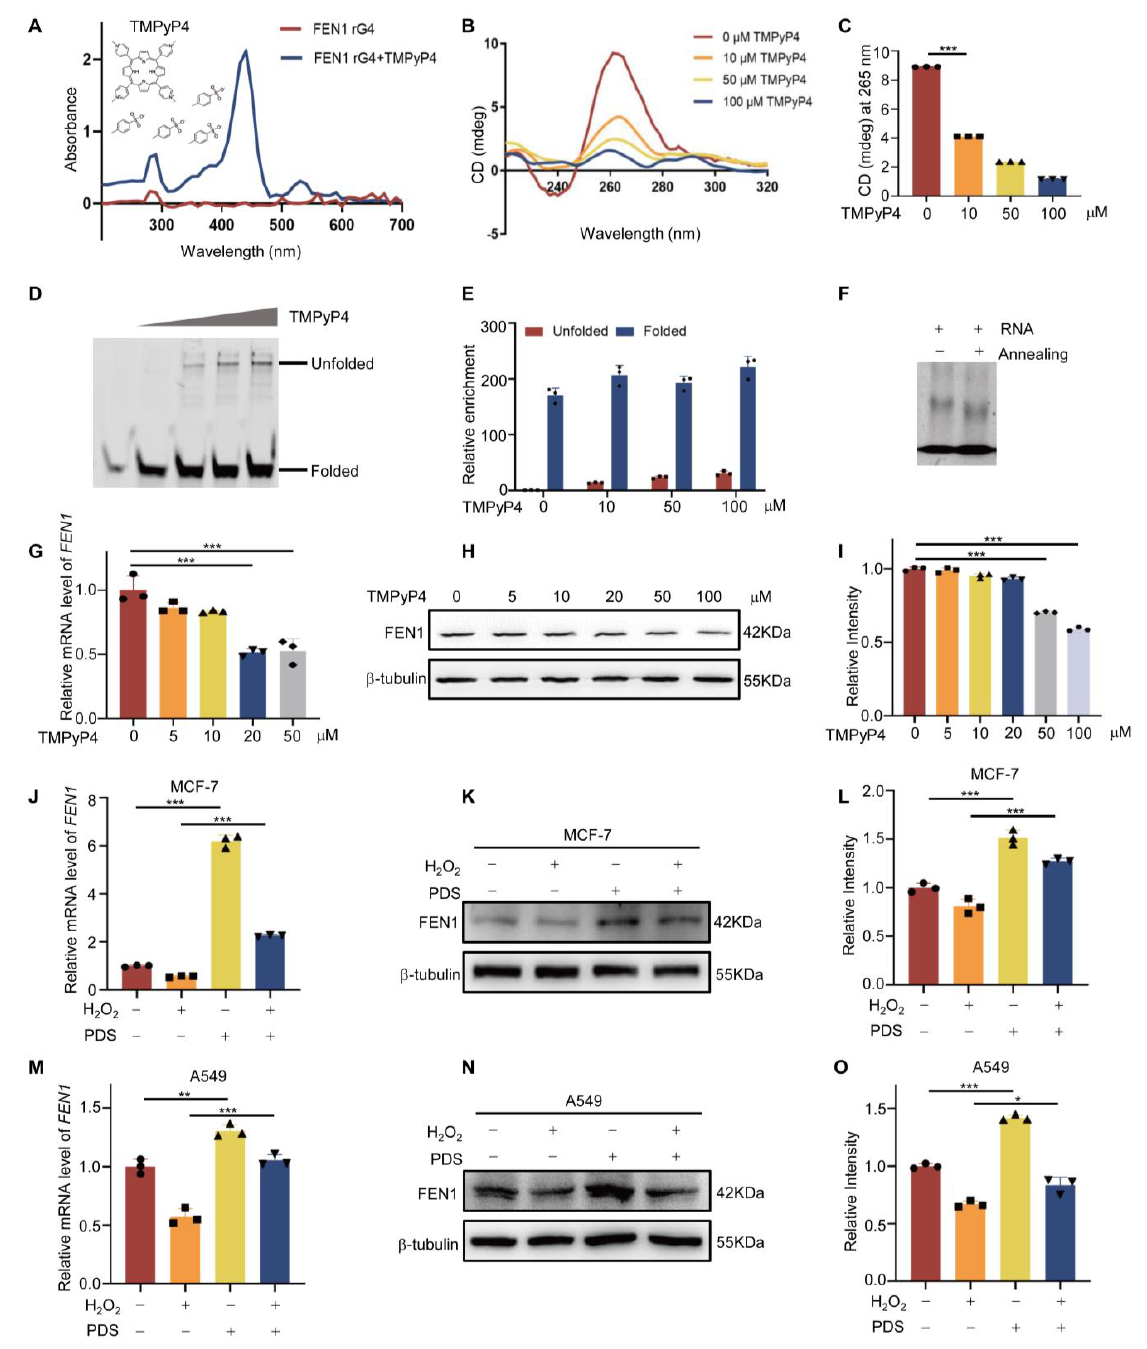
Figure 3. TMPyP4 affects rG4 formation. ( A ) Visible absorption spectra of pre − folded FEN1 rG4 in the absence or presence of TMPyP4. A total of 100 mM of TMPyP4 was added to 5 µ M of the pre − folded FEN1 rG4, then we detected the absorbance value of 200~700 nm. ( B ) CD spectra of 5 µ M pre − folded FEN1 rG4 (in 100 mM KCl) in the absence and presence of increasing concentrations of TMPyP4. ( C ) Statistical analysis of ellipticity at 265 nm for each sample. ( D ) The effect of TMPyP4 on the migration pattern of FEN1 rG4. FAM − labeled RNA or rG4 formed after annealing with or without TMPyP4, and migrated in 12% native − PAGE gel assay. ( E ) Statistical analysis of rG4 folding degree. ( F ) The migration of the annealed or unannealed FAM − labeled RNA or rG4 in the gel was detected by EMSA. ( G ) MCF − 7 cells were treated with different concentrations of TMPyP4 for 12 h. RT − qPCR was used to measure the FEN1 mRNA level and β − actin was used as a loading control. ( H ) Western blot detection of protein changes of FEN1 under different concentrations of TMPyP4 treatment. ( I ) Changes in FEN1 protein concentration by quantitative analysis. ( J ) MCF − 7 cells